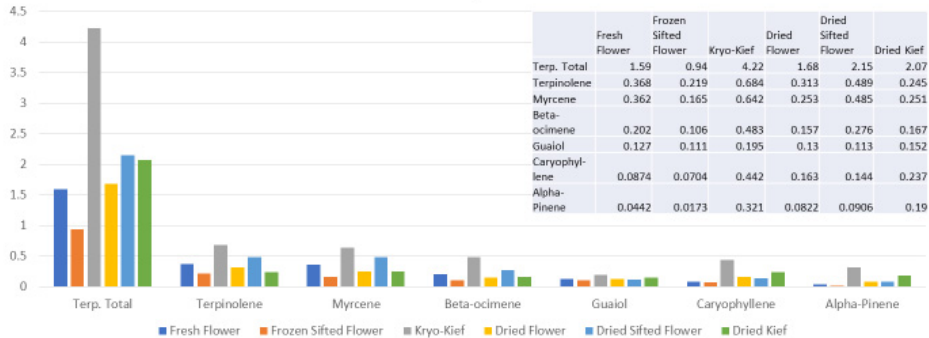
Figure 4. Astral Works Type II chemovar cannabinoid assay results (all figures are %).